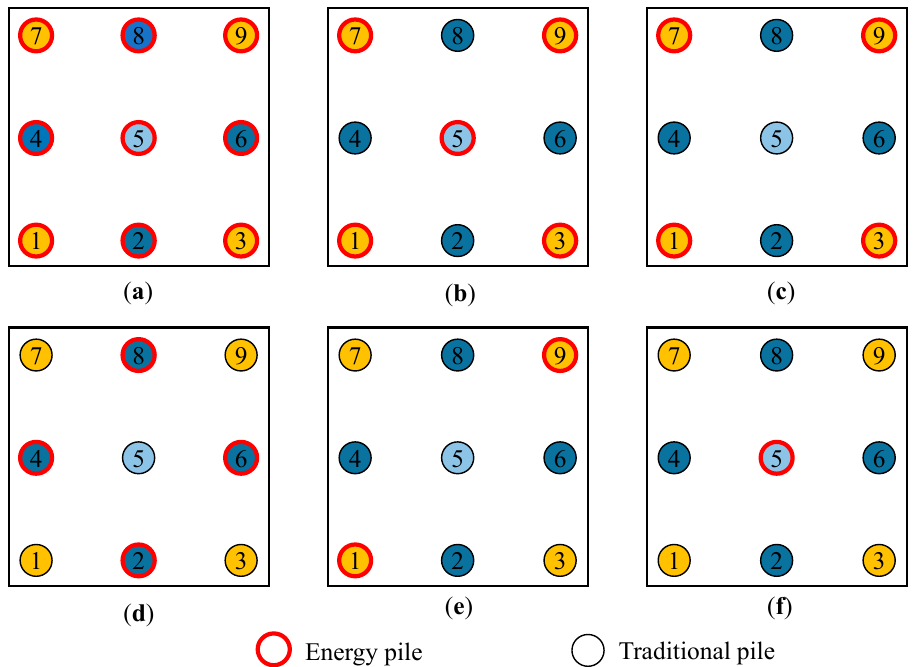
Figure 13. Energy pile layout scenarios. ( a ) Scenario-1. ( b ) Scenario-2. ( c ) Scenario-3. ( d ) Scenario-4. ( e ) Scenario-5. ( f ) Scenario-6.